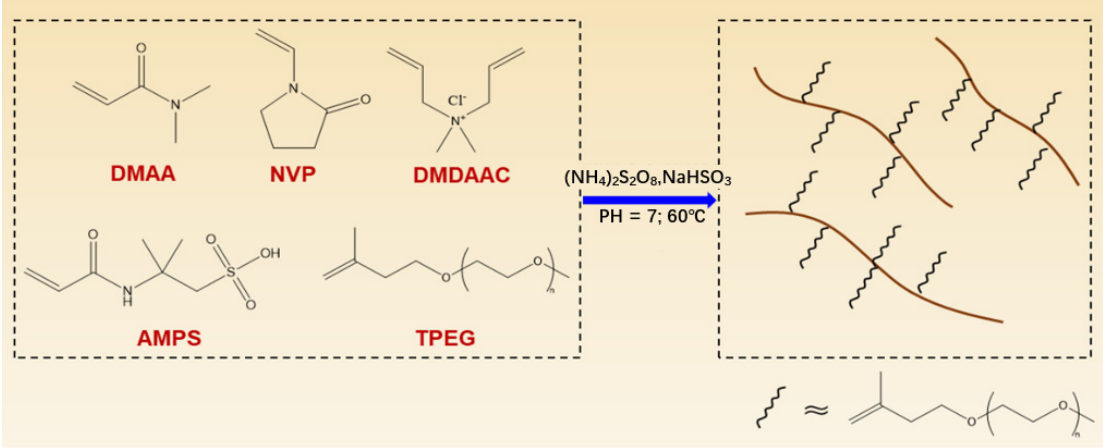
Figure 11. The synthesis procedure of the DNDAP copolymer.